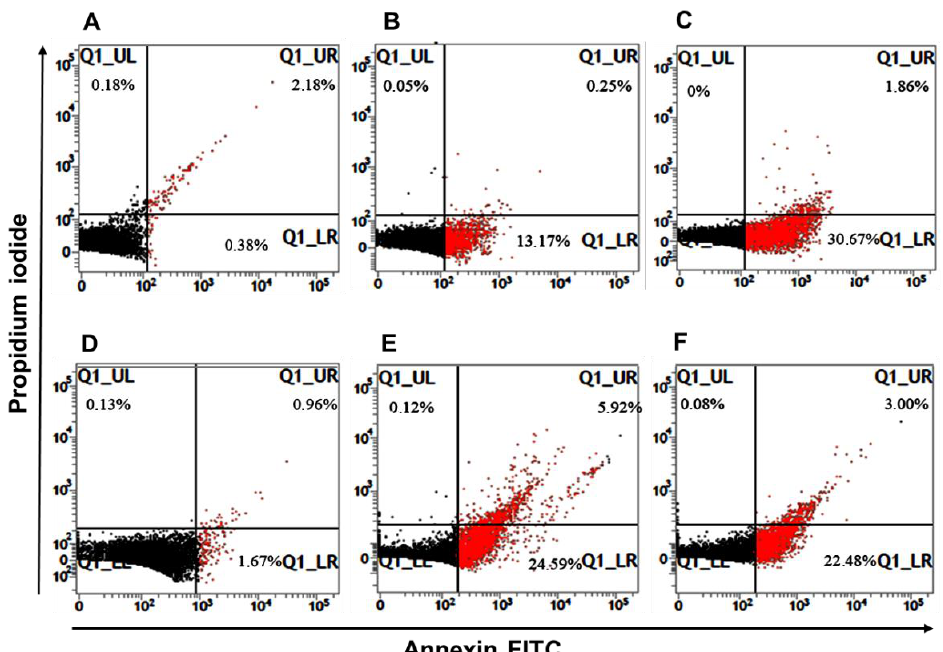
Figure 4. Representative flow cytometry dot-plots of apoptosis-like cell death of Leishmania spp. promastigotes induced by tryptanthrin. ( A ) Untreated L. amazonensis ; ( B ) L. amazonensis treated with amphotericin B (IC50 = 0.68 µ M); ( C ) L. amazonensis treated with tryptanthrin (IC50 = 11 µ M); ( D ) Untreated L. infantum ; ( E ) L. infantum treated with amphotericin B (IC50 = 0.86 µ M); ( F ) L. infantum treated with tryptanthrin (IC50 = 8.0 µ M). Table 2. Flow cytometry analysis of L. amazonensis and L. infantum promastigotes treated with tryptanthrin. The results are demonstrated as the percentage of propidium iodide (necrosis),